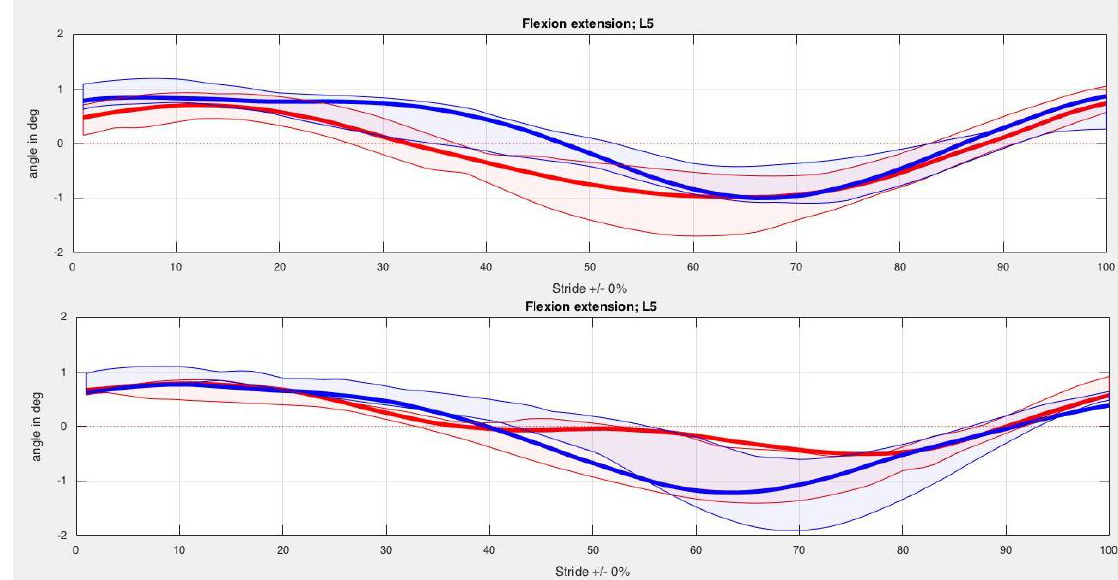
Figure A2. Flexion-extension angular patterns of L5 of horse no. 4 (mean stride) at trot without kinesiotape (the upper graph) and with kinesiotape (the lower graph). The thickened line indicates the mean, shaded area the standard deviation. Left hindlimb red and right hindlimb blue.